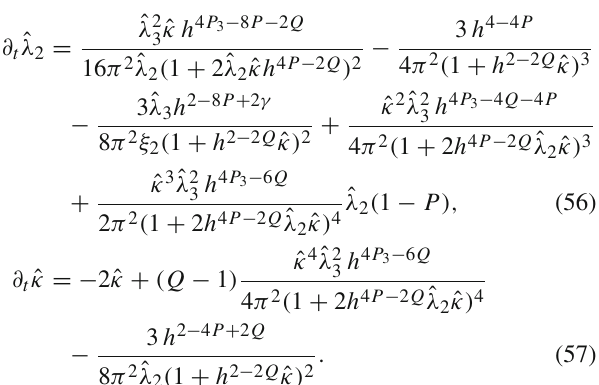
there is only one associated value for the free parameter ˆ λ 3 ; the mag- nified inset near the origin highlights the CEL solution ˆ λ 2 = ˆ λ + Eq. (16). The right panel shows that there are solutions with a positive nontrivial minimum and scalar quartic coupling only for ˆ λ 2 >